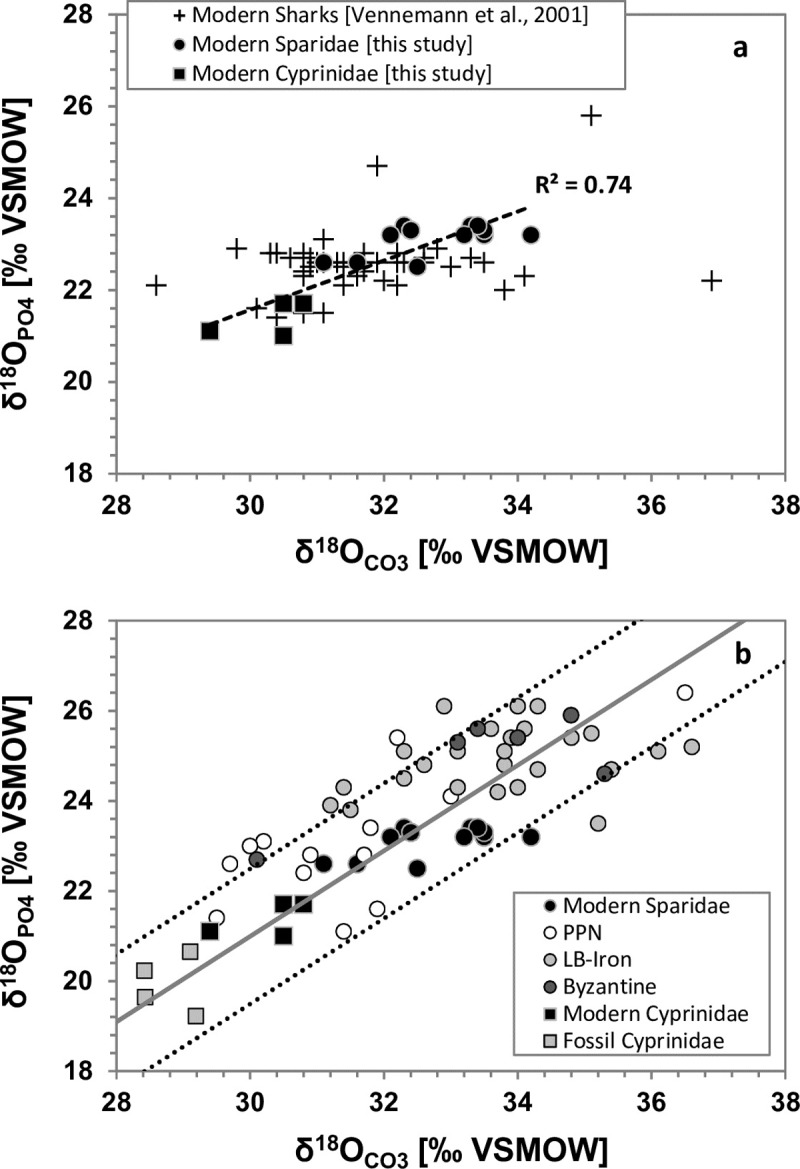
The difference between δ18O of co-existing carbonate and phosphate fractions in enameloid of modern and ancient Sparidae and Cyprinidae teeth.(a) modern sharks, Sparidae and Cyprinidae (b) modern and ancient Sparidae as well as Cyprinidae. The black bold trend line: represents the δ18OPO4/δ18OCO3 relationship of modern mammals after Pellegrini et al. [25]. Note, the Δ18OCO3-PO4 prediction interval (PI) uncertainty of ±1.5‰ (stippled line) reported by Pellegrini et al. [25] agrees well with the range of modern shark teeth [19] and all bony fish data of Sparidae and Cyprinidae fall in this range too. The modern δ18OPO4/δ18OCO3 relationship of Sparidae and Cyprinidae, although yielding high correlation, covers a narrow δ18OPO4/δ18OCO3 range to allow comparison with the δ18OPO4/δ18OCO3 relationship of mammals. More data is needed to establish the δ18OPO4/δ18OCO3 relationship in modern bony fish.